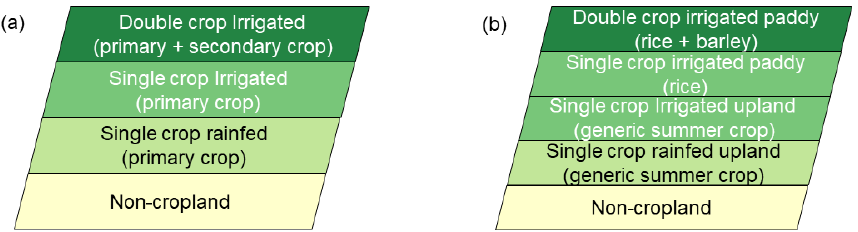
Figure 4. Grid cell categorization, with (a) the original categorization for the global mode and (b) the new categorization for the localized